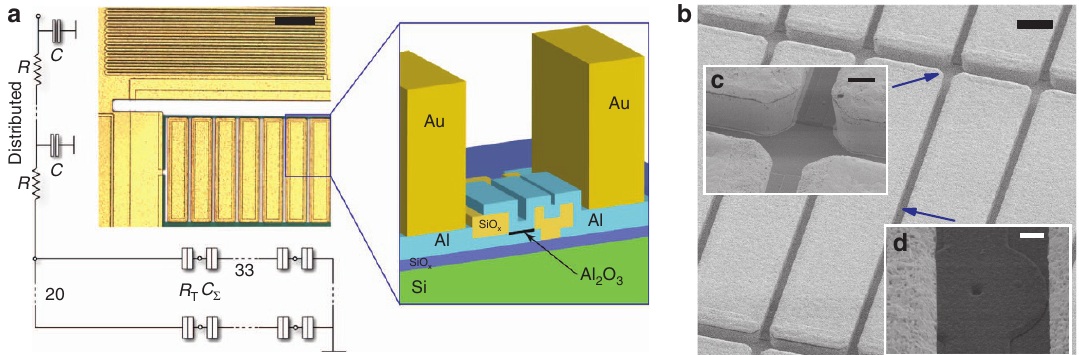
Figure 1 | Details of the CBT device structure. ( a ) Optical micrograph of the CBT with equivalent circuit diagram and schematic cross-section of the structure. Scale bar on the optical micrograph, 10 m m. The CBT is formed of 32 (cid:3) 20 metallic islands of capacitance C S connected in an array by tunnel junctions of resistance R T , as shown in the circuit diagram. Connection to the array is made via on-chip RC filters comprising a meandering electrode sandwiched between large-area grounded metal films, separated by 250nm SiO x . Each filter has a distributed resistance R E 500 O and capacitance C E 10pF. The schematic cross-section shows one Al 2 O 3 tunnel junction connecting two Al islands, with Au thermalization blocks on top of each. ( b ) Scanning electron microscopic (SEM) image showing Au thermalization blocks. Scale bar, 20 m m. ( c ) The sidewalls of four adjacent Au blocks. Scale bar, 4 m m. ( d ) One tunnel junction connecting two adjacent blocks. Scale bar, 1 m